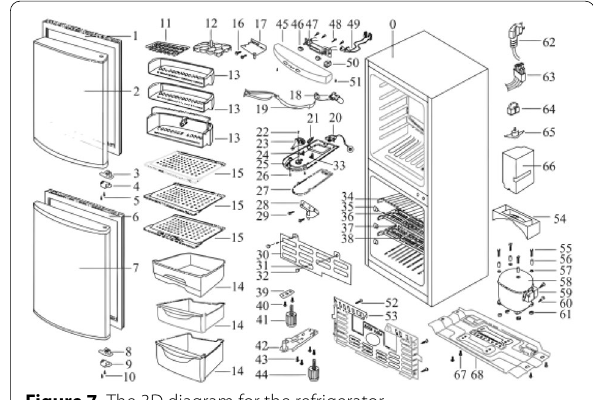
Figure 7 The 3D diagram for the refrigerator